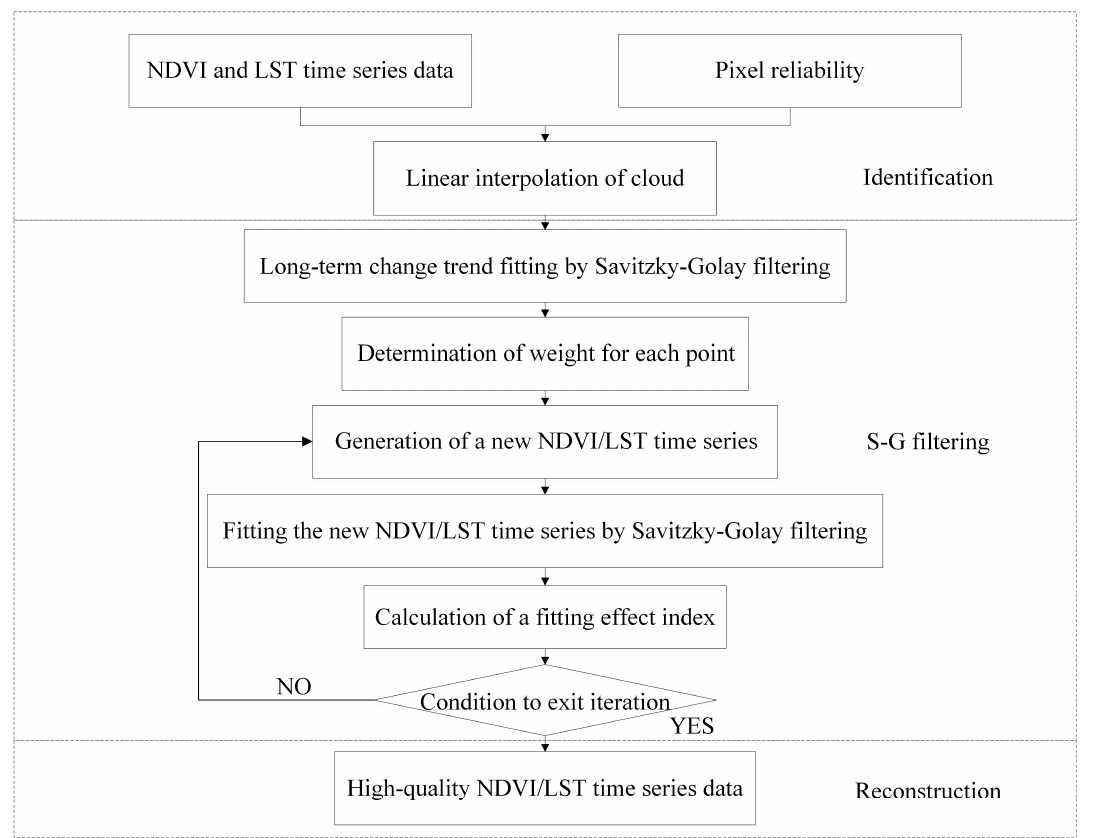
Figure 2. Flowchart of Savitzky–Golay (S-G) Filtering Method.